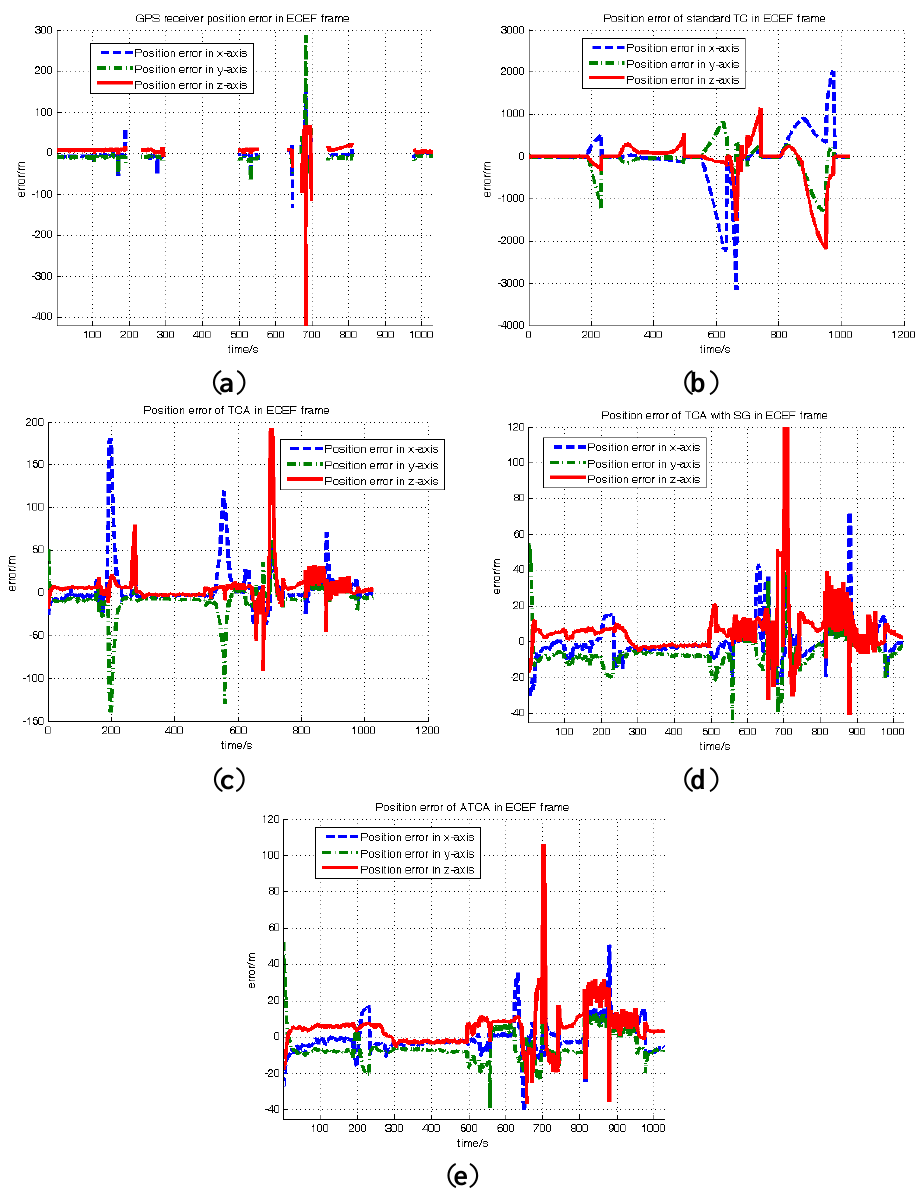
Figure 9. Position errors of different methods: ( a ) GNSS receiver error; ( b ) standard TC position error; ( c ) TCA position error; ( d ) TCA with SG position error; ( e ) ATCA position